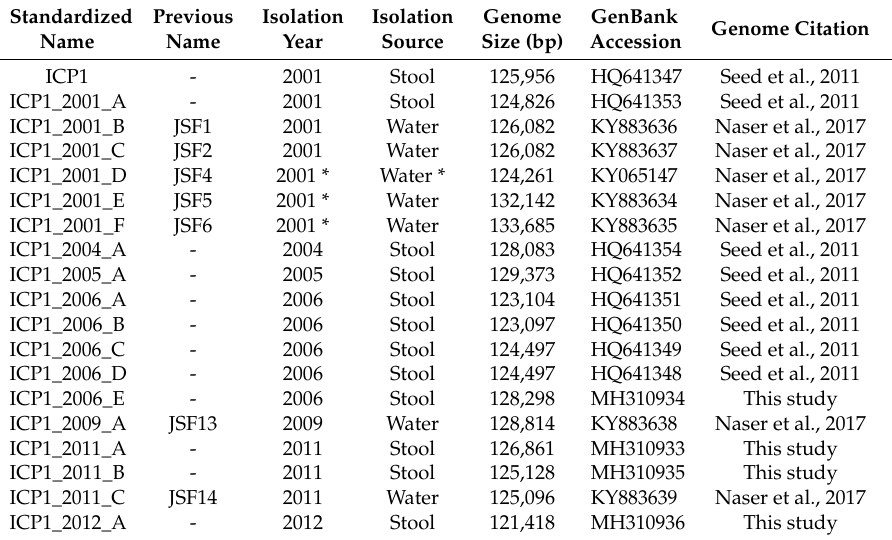
Table 1. ICP1 (International Centre for Diarrhoeal Disease Research, Bangladesh cholera phage 1) bacteriophage